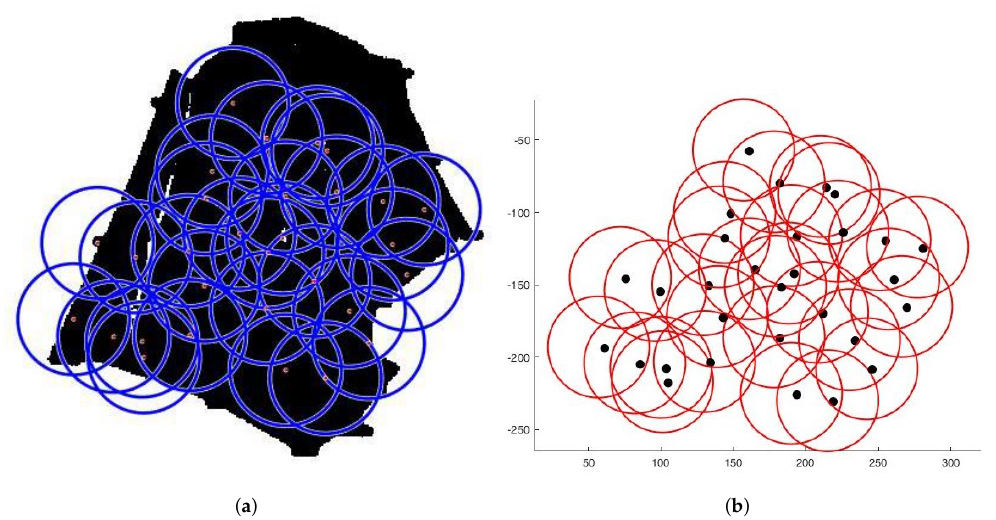
Figure 10. Deployment on first area. ( a ) Final positioning. ( b ) Connectivity scheme.